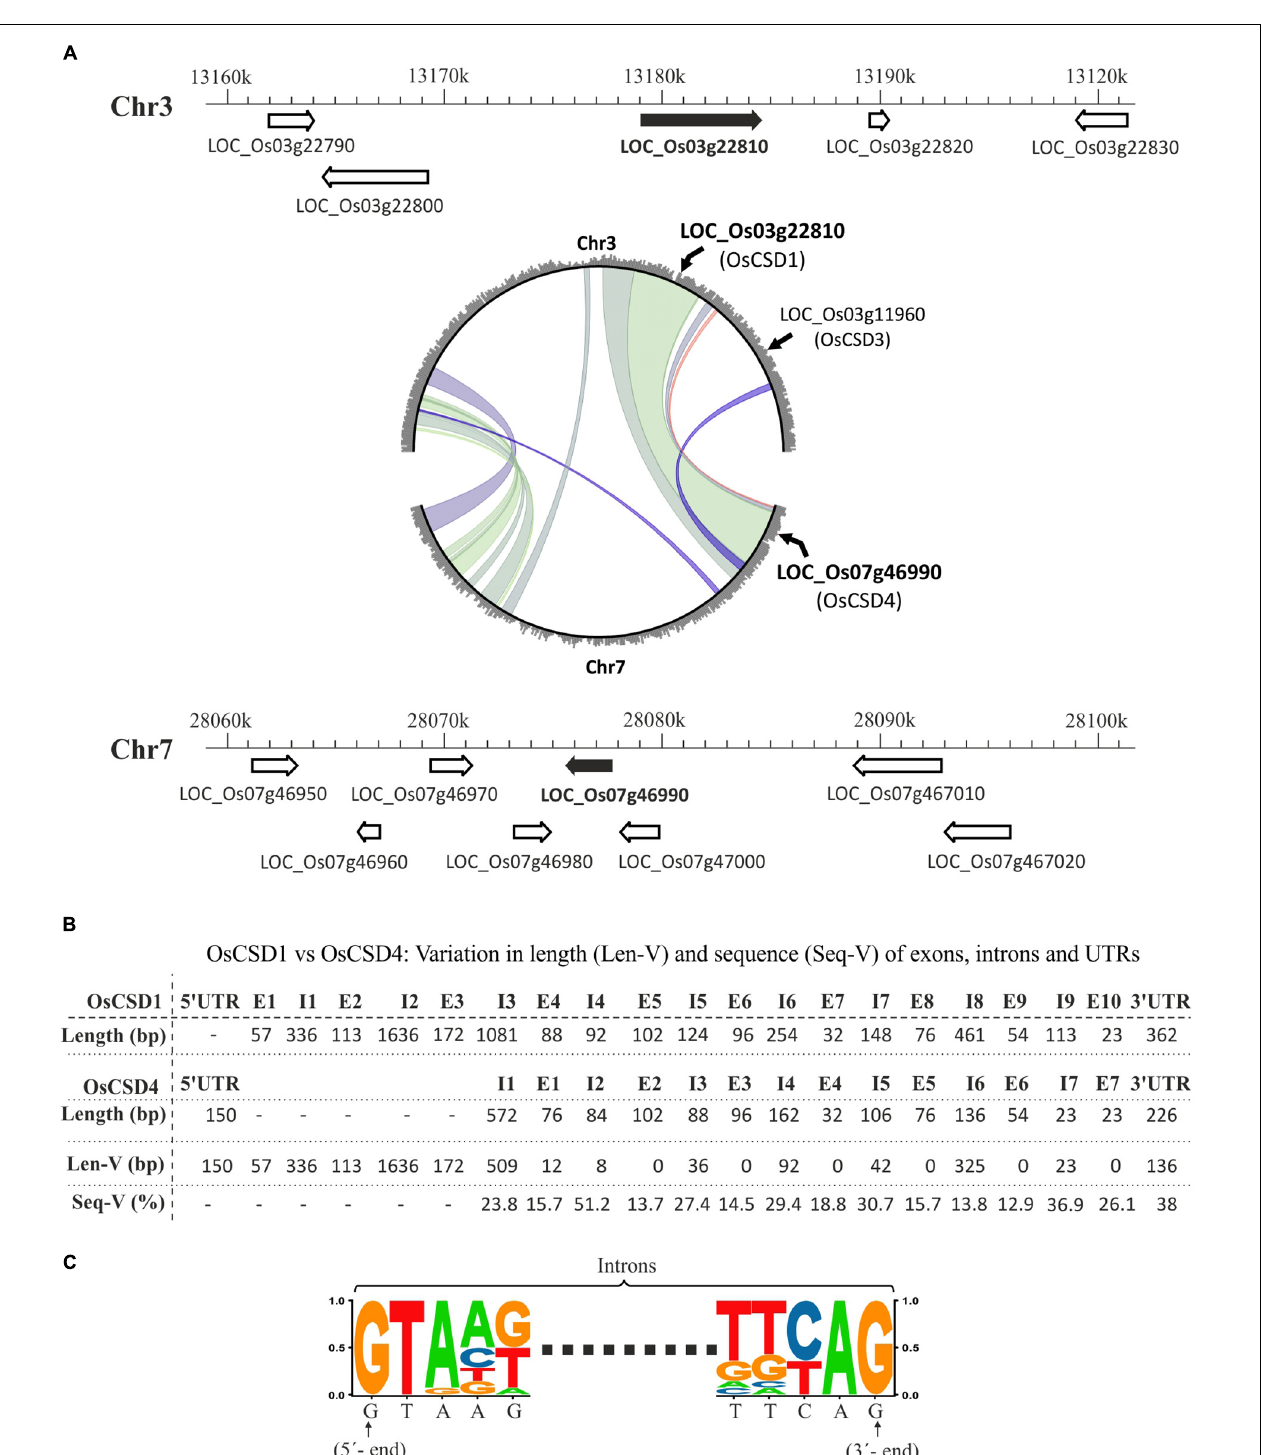
FIGURE 1 | (A) Schematic representation of chromosomal locations encoding two rice cytosolic CuZn SODs, OsCSD1 (LOC_Os03g22810, chromosome 3, Chr3) and OsCSD4 (LOC_Os07g46990, chromosome 7, Chr7) as per RGAP database. The neighboring genes are shown with arrowheads indicating the direction of the transcription, while the scale indicates the chromosomal coordinates. The circle plot generated at the Monocot PLAZA 4.5 web server shows segmental duplications between chromosomes 3 and 7 along with positions of region-harboring rice cytosolic CSDs (LOC_Os03g22810, LOC_Os07g46990) and peroxisomal CSD (LOC_Os03g11960). (B) Overview of variation in length (Len-V) and sequence (Seq-V) between the UTRs, exons, and introns of OsCSD1 and OsCSD4 genes. (C) Sequence logo generated by aligning the 5 (cid:48) - and 3 (cid:48) -ends of the all introns of OsCSD1 and OsCSD4 genes.